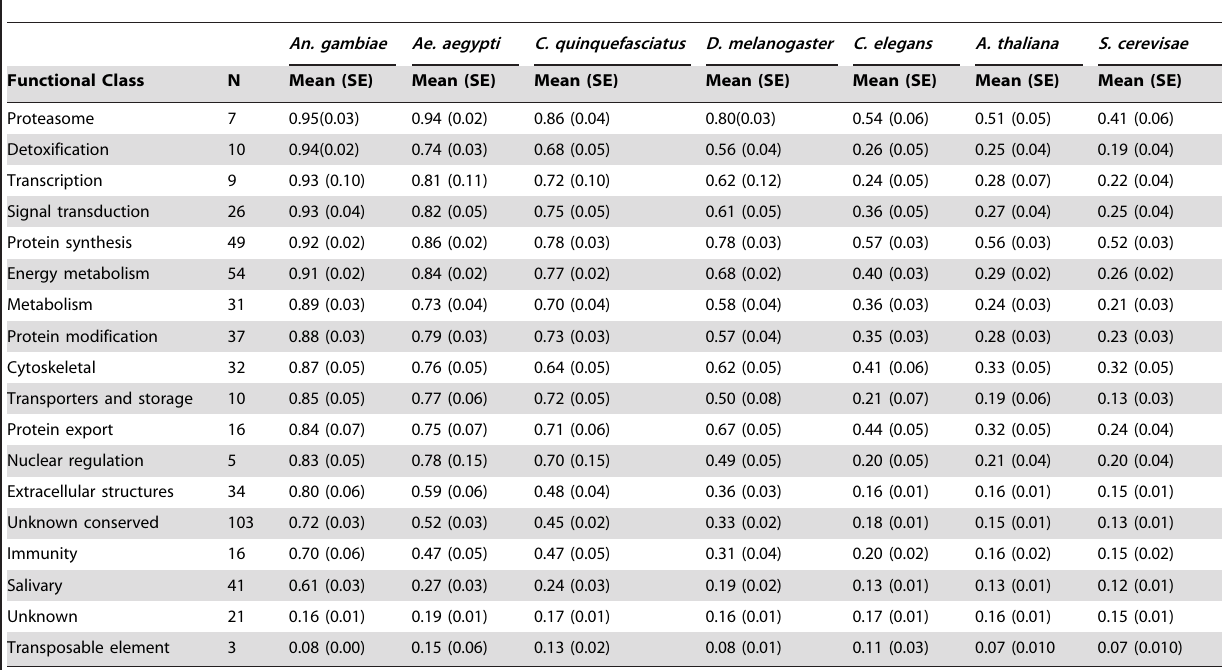
Table 2. Similarity of Anopheles funestus proteins to best matching homologues of An. gambiae , Aedes aegypti , Culex quinquefasciatus , Drosophila melanogaster , Caenorhabditis elegans , Arabidopsis thaliana and Saccharomyces cerevisae .